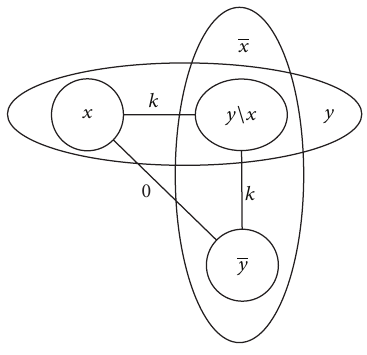
Figure 2: Cuts 𝑥 and 𝑦 in the case of 𝑥 ⊂ 𝑦 .